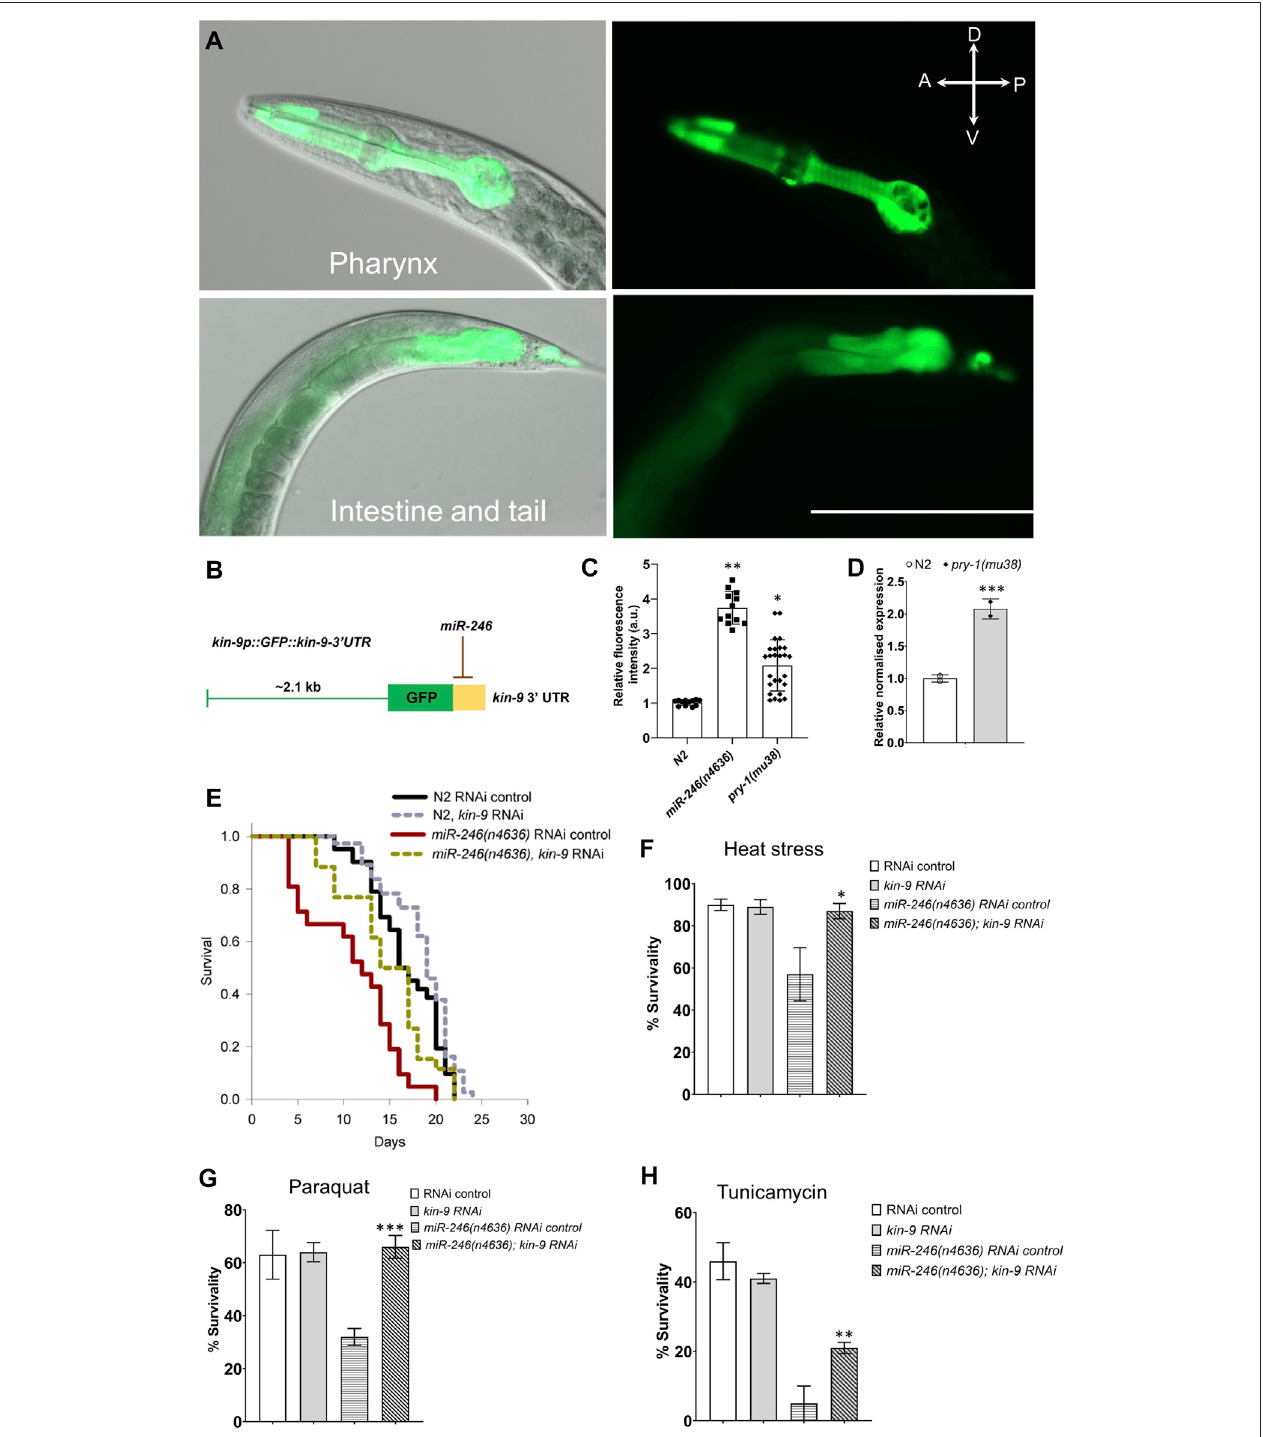
FIGURE 4 | Lowering kin-9 activity suppresses miR-246 mutant defects. (A) kin-9p (2.1 kb):GFP analysis shows expression in the pharynx, intestine, and tail neurons. (B) Schematic diagram of a kin-9p::GFP::kin-9 3 ′ UTR construct showing potential miR-246 binding at the 3 ′ UTR of the kin-9 mRNA transcript. (C) Bar graph showing the GFP analysis using the array kin-9p::GFP::kin-9 3 ′ UTR in miR-246 (n4636) and pry-1(mu38) adults compared to control. Data represent the mean of two replicates ( n > 25 animals in each replicate) and error bars represent the standard deviation. Statistical analyses were done using one-way ANOVA with Dunnett ’ s post hoc test and signi fi cant differences are indicated by stars (*): * ( p < 0.05), ** ( p < 0.01). (D) qPCR analysis of kin-9 gene in the pry-1(mu38) adults compared to control. Data represent the mean of two replicates and error bars the standard error of means. Signi fi cance was calculated using Bio-Rad software (one-way ANOVA)